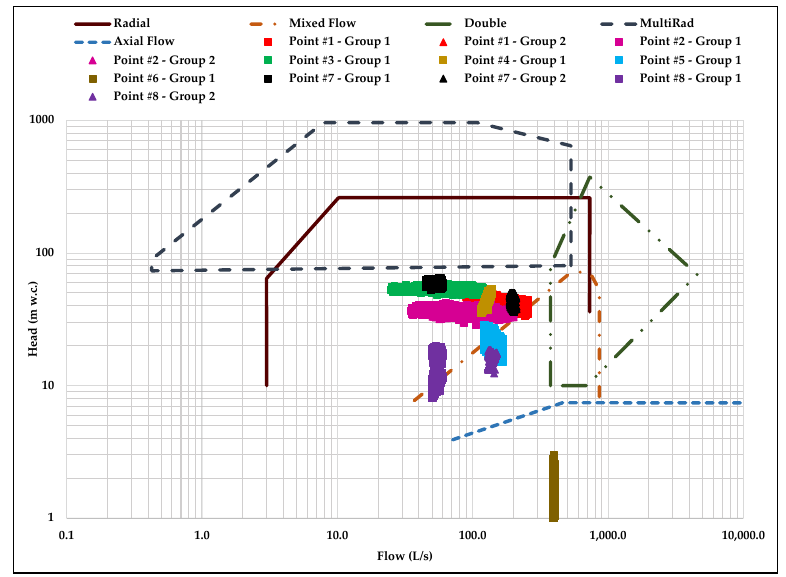
Figure 8. Classification for each PAT as a function of the representative operational point for each analyzed